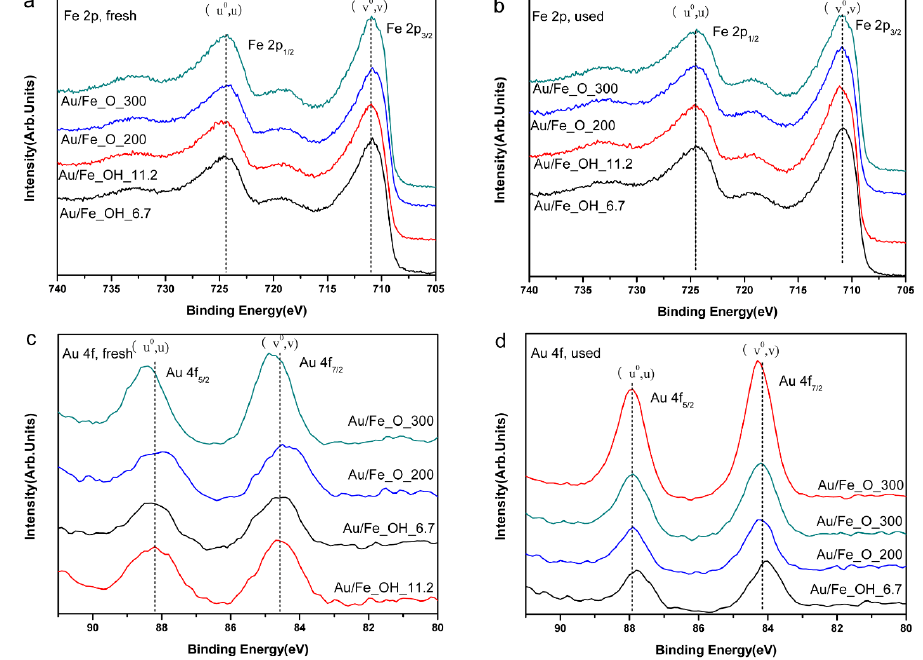
Figure 7. XPS spectra of Au/FeO x catalysts: ( a ) Fe 2p, fresh; ( b ) Fe 2p, used; ( c ) Au 4f, fresh; and ( d ) Au 4f, used.